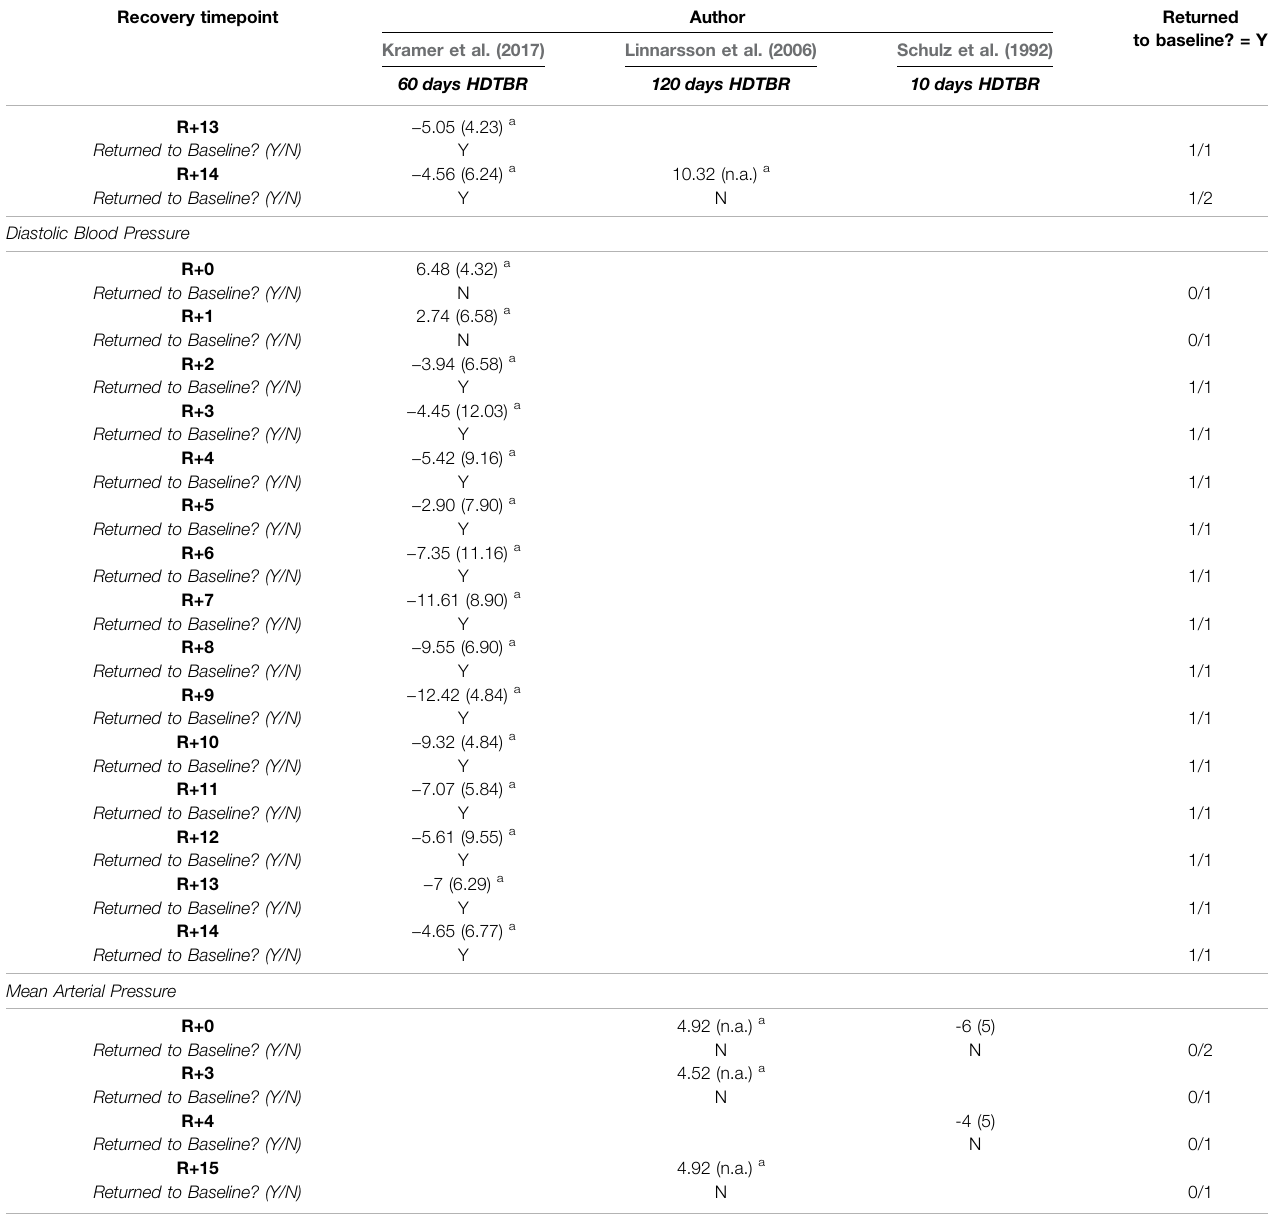
TABLE 6 | ( Continued ) % Change with SD of outcome parameters related to the ‘ Cardiovascular System ’